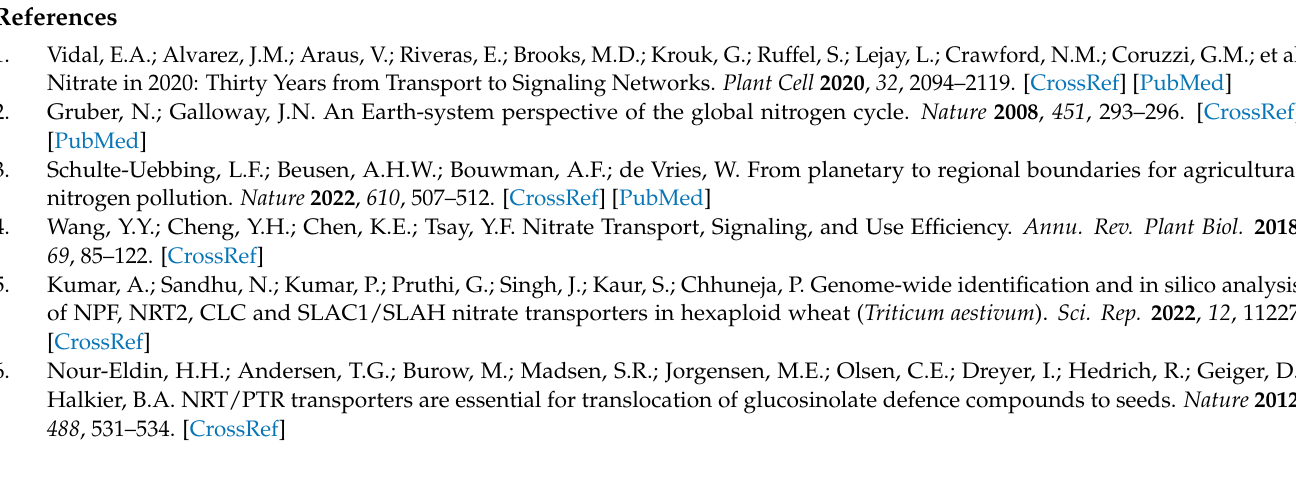
genes. Table S3: Expression profiles of CsNPF genes in different organs. Table S4: RNA-seq of CsNPF genes under salt, heat, and cold stress. Table S5: FPKM values of CsNPF genes under N deficiency treatments. Table S6: List of qRT–PCR primers used in this